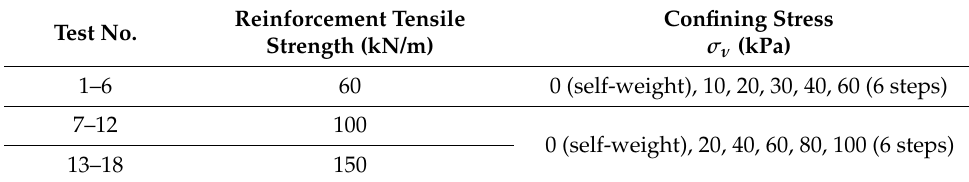
Table 3. Conditions of the pullout test.